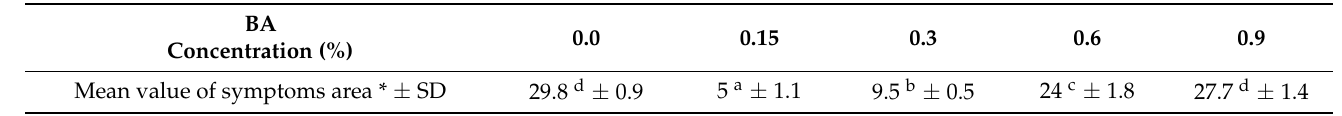
Table 5. Effect of tomato plants pretreatment with BA on the severity of early blight symptoms, caused by Alternaria alternata 14 days post-inoculation.